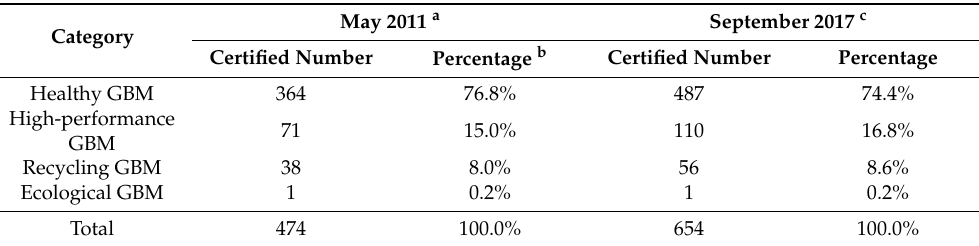
Table 5. Statistics on certified GBM in